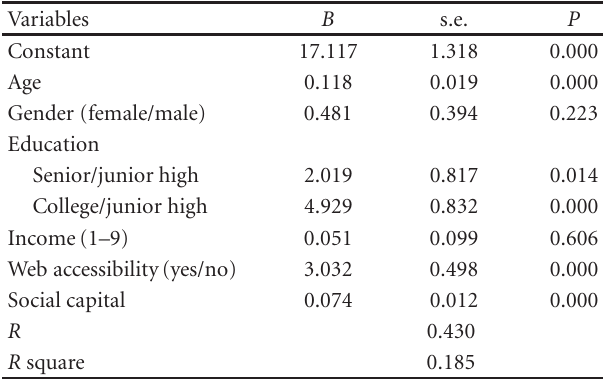
Table 4: Factors influencing technological literacy.